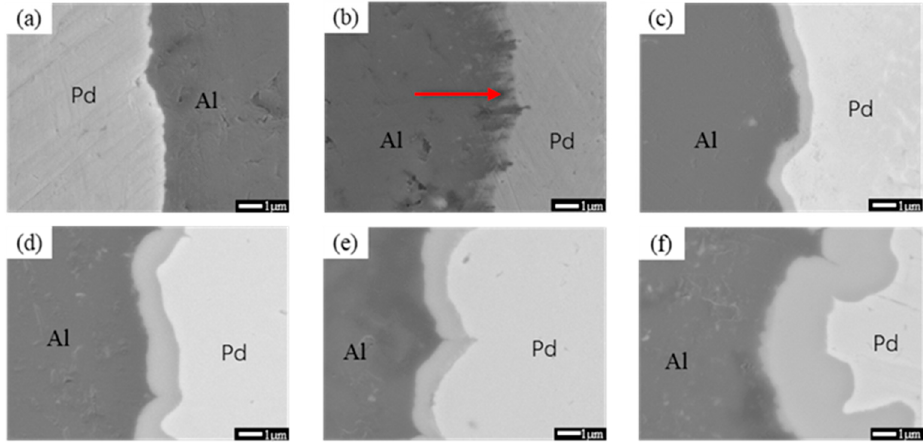
Figure 6. SEM images of Pd/Al composite wires annealed at 300 °C for different times; ( a ) 5 s, ( b ) 60 s, ( c ) 900 s, ( d ) 3600 s, ( e ) 7200 s, and ( f ) 10,800 s. ( c ) 900 s, ( d ) 3600 s, ( e ) 7200 s, and ( f ) 10,800